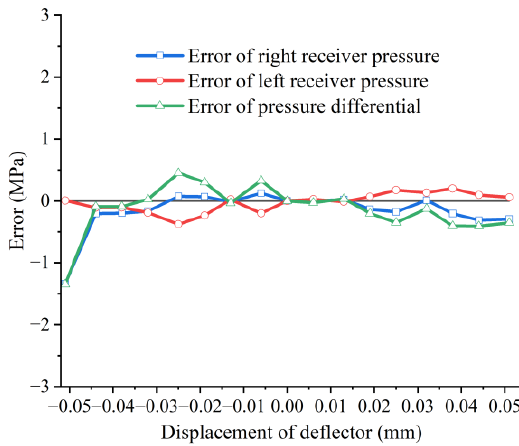
Figure 20. Calculation errors of pressures.